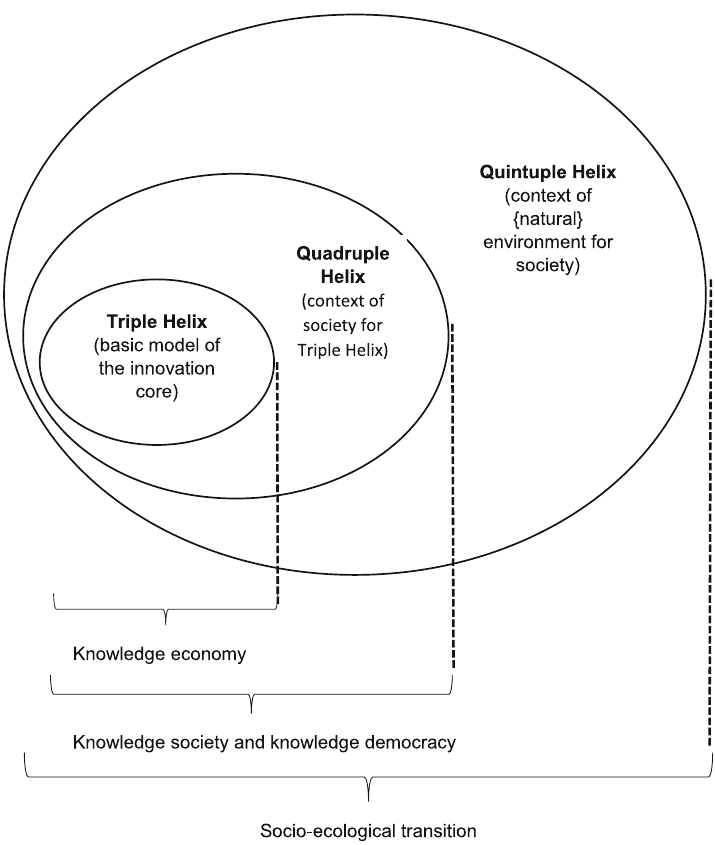
Fig. 1 Knowledge production and innovation in the context of the knowledge economy, knowledge society(knowledge democracy), and the natural enviroments od society. Modified frome carayannis and Campbell (2012, p.18), Etzkowitz and Leydesdorff (2000, p.112) and Danilda et al.